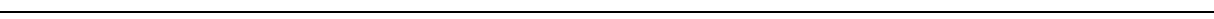
Fig. 2 Validation of CRISPR-Cas-mediated mutagenesis scanning as a target identi fi cation approach using large sgRNA tiling libraries. a Overview of the work fl ow for the CRISPR-Cas9-based target identi fi cation screen used for bortezomib. Two lentiviral sgRNA sublibraries, together tiling 115 genes targeted by FDA-approved anticancer drugs, were constructed (A: ABL1 through HDAC9 ; B: IFNAR1 through VEGFB ). Sublibrary B was transduced into HAP1 cells stably expressing SpCas9, enriched with puromycin and treated with 30 nM bortezomib for 19 days. sgRNAs in the surviving cells were then sequenced and validated. b Cell viability of parental and the pool of bortezomib-resistant HAP1 cells in the presence of different concentrations of bortezomib. Data points represent mean ± s.d. obtained from three experiments performed in triplicate. c Representation of the different sgRNAs in cells before (after puromycin selection) and after treatment with 30 nM bortezomib as determined by EdgeR analysis of next-generation sequencing data. Each dot represents a different sgRNA. A value of 1 was added to each read count to facilitate log transformation. d Overview of the sgRNA hits enriched in the bortezomib-surviving cells. e Validation of the individual sgRNA hits by assessing their ability to induce bortezomib resistance. Individual sgRNAs were cloned into an expression vector and transfected separately into SpCas9 + HAP1 cells. Cells were treated with 20 nM bortezomib for 8 days and then counted using trypan blue exclusion. An sgRNA targeting the AAVS1 safe harbor locus was used as negative control. The columns represent mean ± s.d. obtained from two separate experiments. f PSMB5 amino-acid variants present in the pool of bortezomib-resistant cells as determined by CrispRVariants analysis of next-generation targeted amplicon sequencing. g PSMB5 chymotrypsin-like activity as measured in parental HAP1 and a single-cell-derived PSMB5 A108T mutant obtained from the pool of bortezomib-resistant cells. Cells were untreated or treated for 2 h with 12.5 nM bortezomib. Values represent mean ± s.d. obtained from a single experiment performed in triplicate; * p -value < 0.05 *, **** p -value < 0.0001 (two-way ANOVA with Bonferroni correction for multiple testing), ns not signi fi cant, RLU relative light